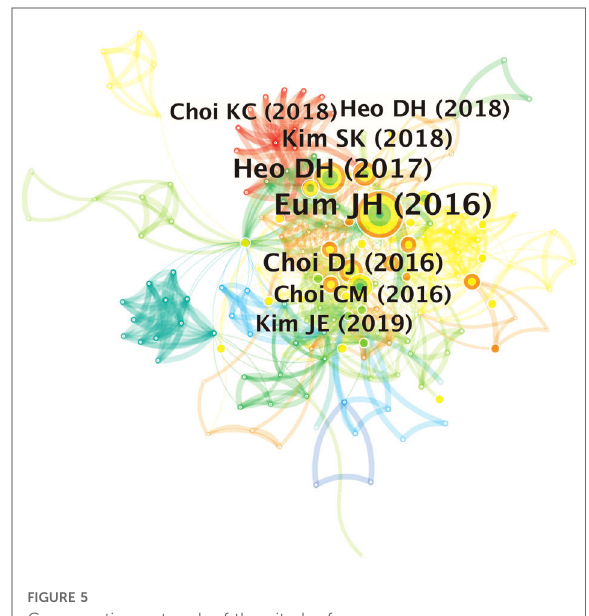
FIGURE 5 Co-operation network of the cited references.